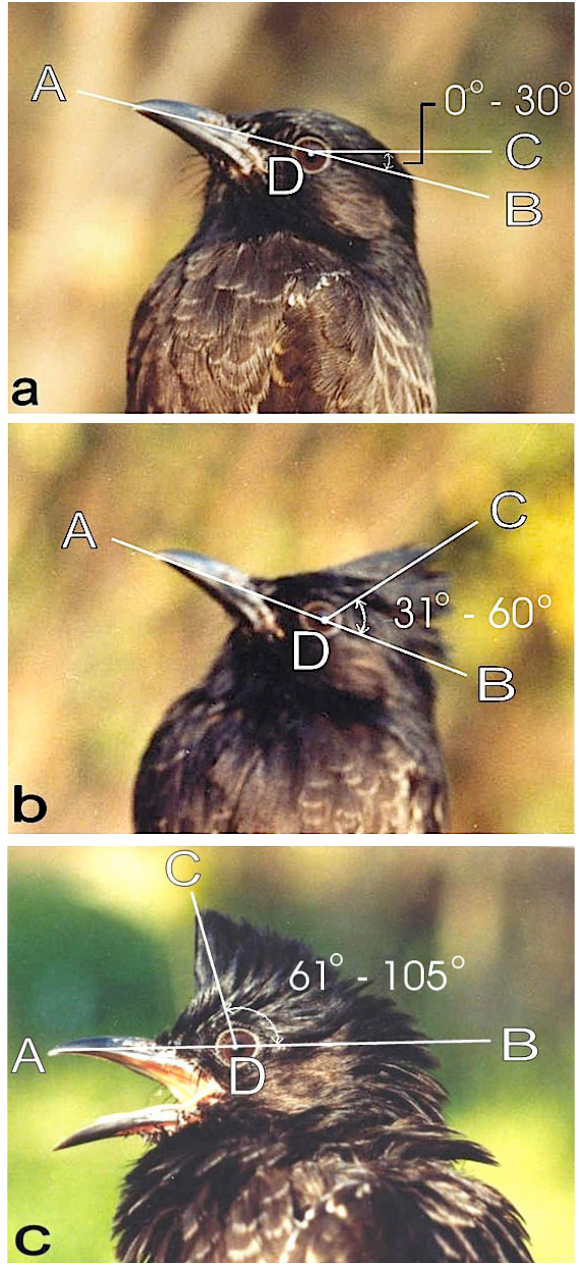
used.Image 5. Showing the different levels of crest and corresponding range of angle of elevation, (a) Down- crest position, (b) Middle-crest position, and (c) Up-crest